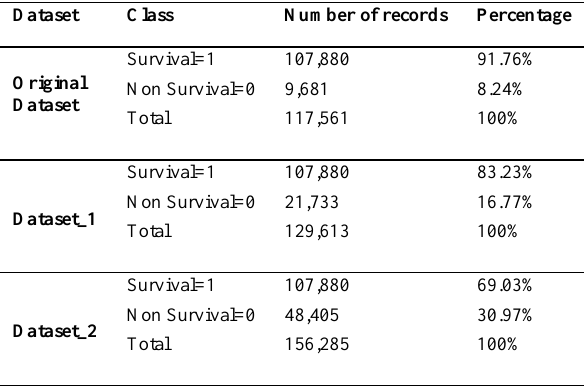
Table 1. Distribution of class variable. Dataset_1 and Dataset_2 are new generated datasets by applying Borderline-SMOTE and DSO to original dataset,